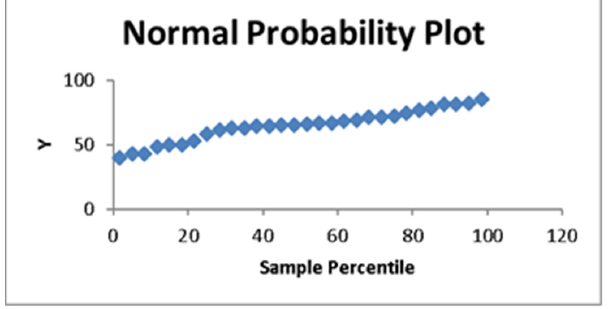
Figure 1. Confidence in the linear model.